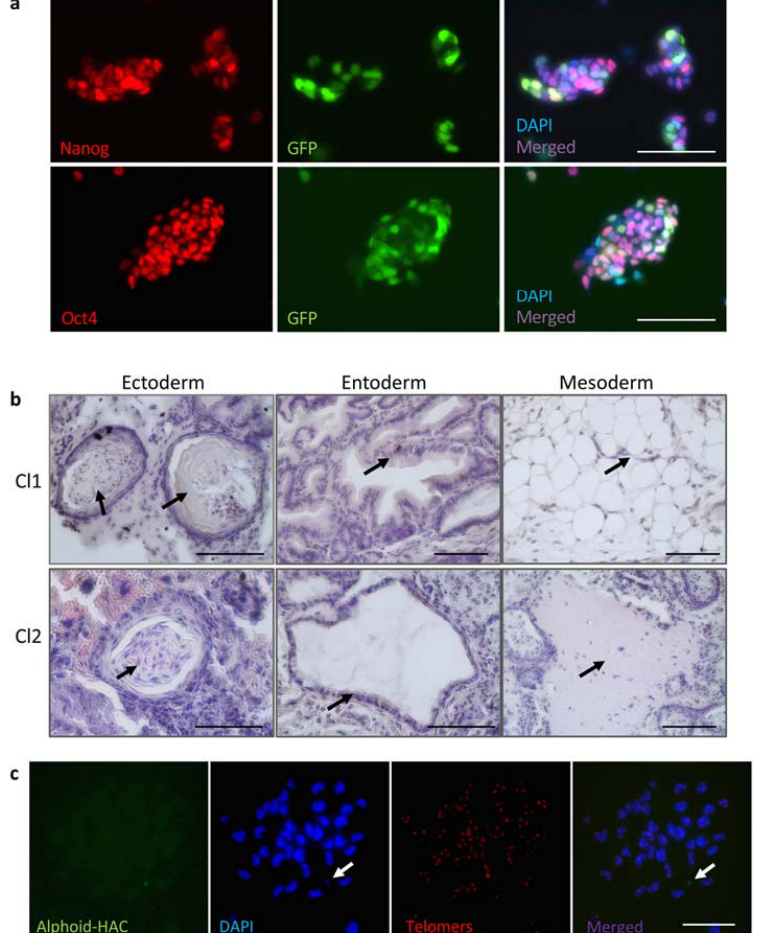
Figure 4. Characterization of FVIII Y / - iPSCs bearing the alphoid tetO -HAC-FVIII. ( a ) Immunostaining of FVIII Y/ ‐ iPSC cells bearing the alphoid tetO ‐ HAC ‐ FVIII (clone 2) with anti ‐ Nanog antibodies (upper panel), and with anti-Oct4 antibodies (lower panel). Scale bar—100 µ m, color-coded markers are indicated on the panels. ( b ) Clone 1 (Cl1) and clone 2 (Cl2) differentiate in tissues of all three embryonic germ layers in the teratoma assay: keratin epidermis of ectoderm (Cl1 and Cl2); gut epithelium (Cl1) and gland (Cl2) of entoderm; adipocytes (Cl1) and cartilage (Cl2) of mesoderm. Scale bar—100 µ m. ( c ) FISH assay of the FVIII Y / - iPS-HAC-FVIII (clone 2 Cl2) with the alphoid tetO PNA-FITC probe (green) and the telomere PNA-TRITS probe (red). The alphoid tetO -HAC-FVIII is indicated by an arrow. Scale bar—10 µ m, color-coded markers are indicated on the